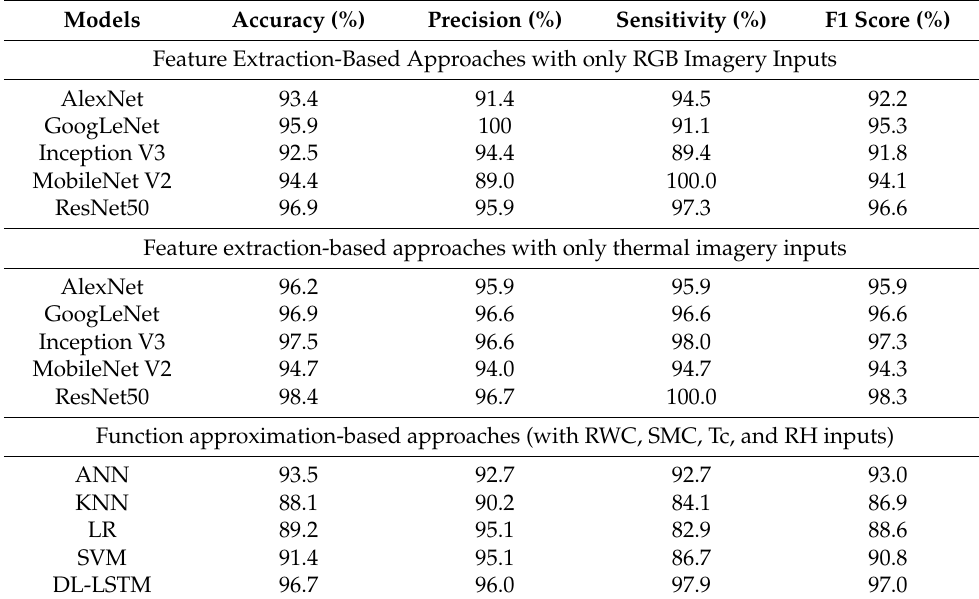
Figure 6. Accuracy and loss curves for ( a ) AlexNet; ( b ) GoogLeNet; ( c ) Inception V3; ( d ) MobileNet V2; and ( e ) ResNet50 models with thermal imagery inputs for crop water stress identification. Table 6. Validation performance of feature extraction and function approximation models to characterize wheat water stress.